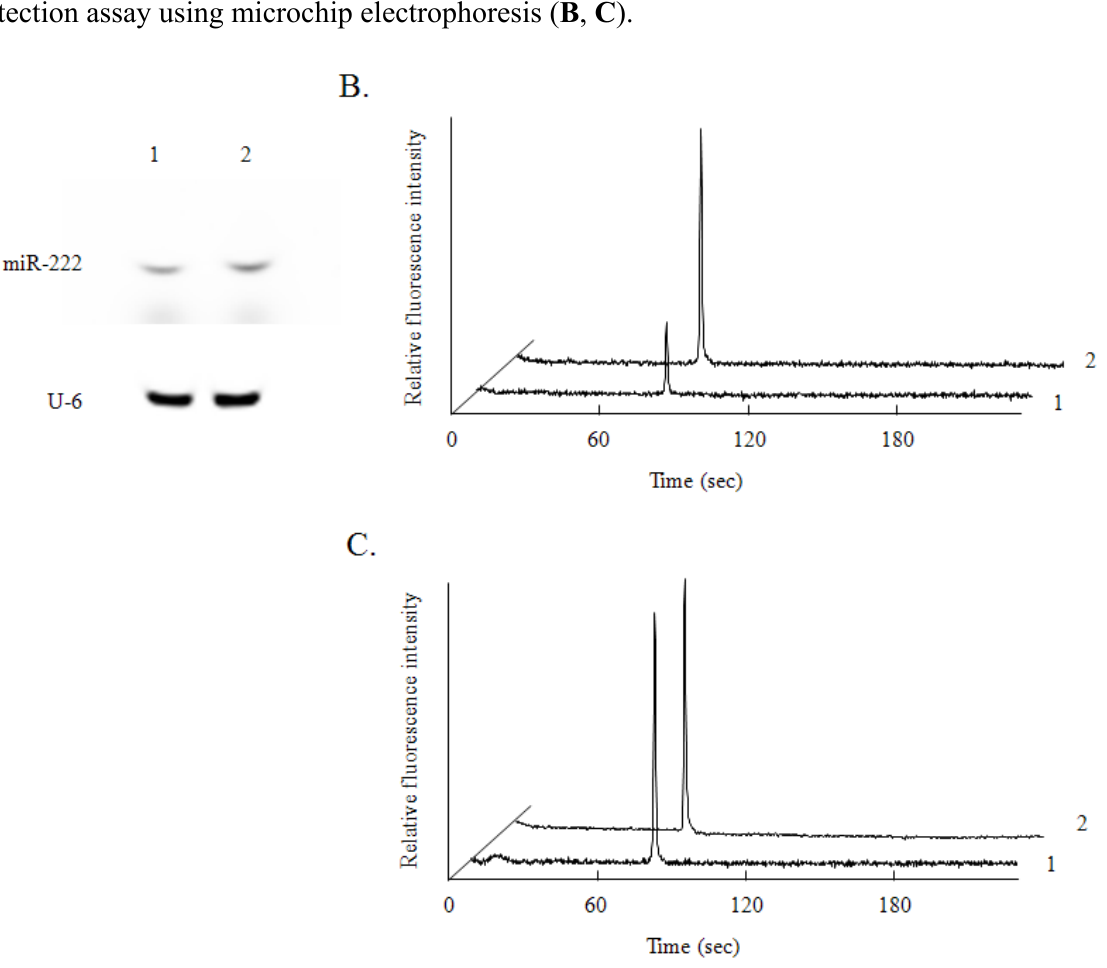
Figure 3. Analysis of miR-222 expression in PC12 cell cultures with (lane 2) or without (lane 1) NGF treatment by the conventional RNase protection assay ( A ) and by the RNase protection assay using microchip electrophoresis ( B , C